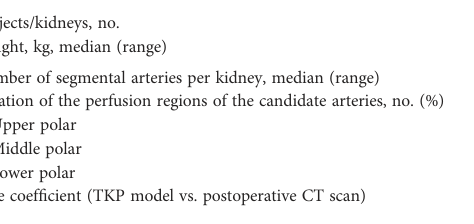
TABLE 3 Validation results of TKP model in porcine models. Variables Subjects/kidneys, no. Weight, kg, median (range) Number of segmental arteries per kidney, median (range) Location of the perfusion regions of the candidate arteries, no. (%)